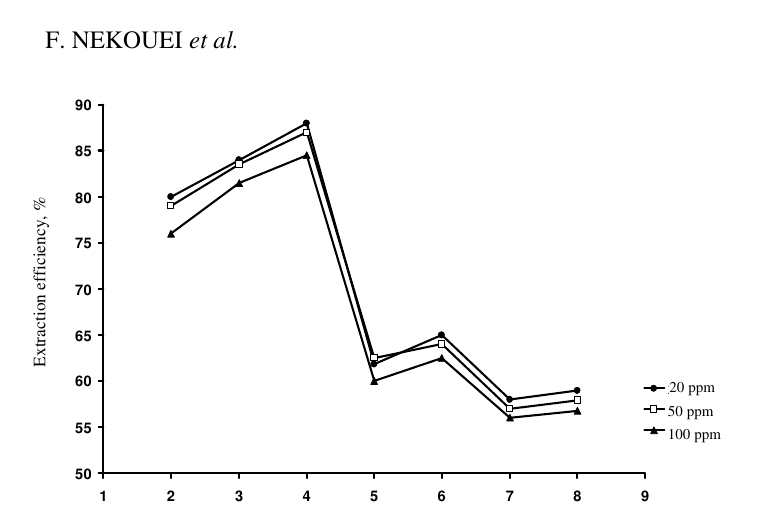
Figure 2. Effect of pH on removal of direct yellow 12 ( Conditions: 50 mL of solution containing different concentration of dye (20, 50 and 100 ppm), 0.4 M of NaCl and 0.09 M of triton x-100, equilibration temp 75 o C and equilibration time 20 min, centrifuge time 10 min and centrifuge rates 3500 rpm)